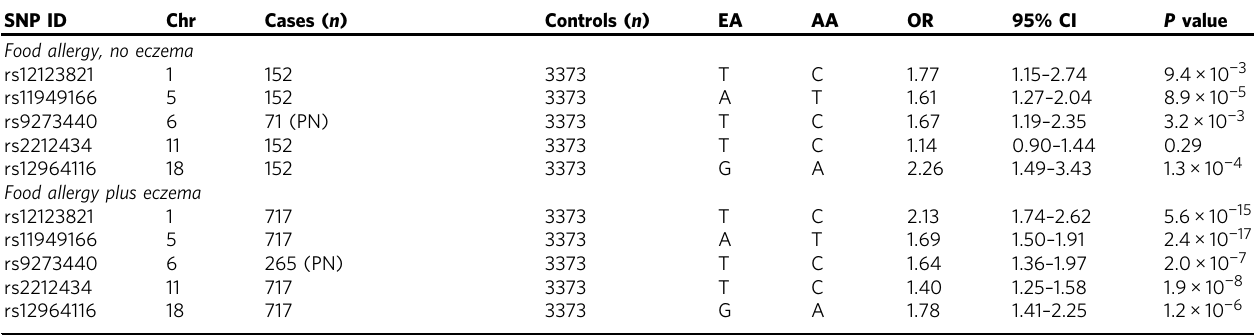
Table 3 Risk estimates for the identi fi ed food allergy loci dependent on the eczema